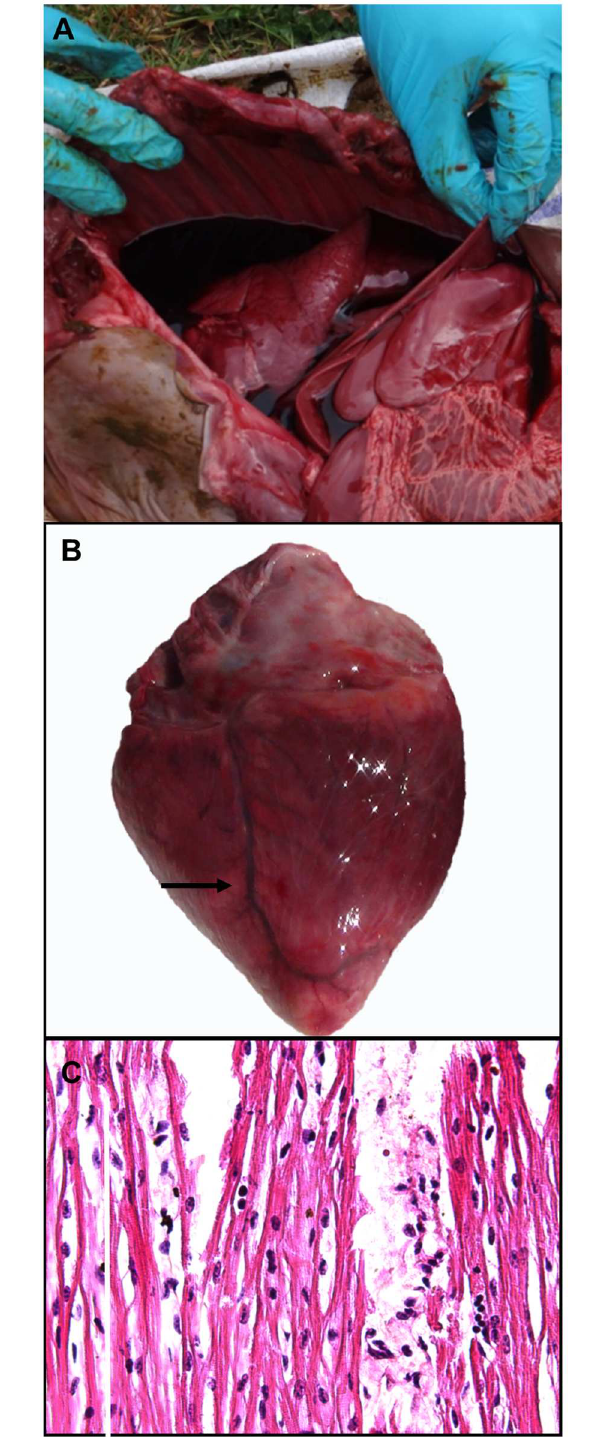
Fig 1. Gross and histopathological findings of FMDV-associated myocarditis in still-borne calf. (A) Sanguineous bicavitaryeffusions in still-bornecalf from Dam ID#454. (B) Focal myocarditis seen as area of pallor (arrow) on epicardialsurface of heart from aborted calf shown in panel (A). (C) Mixed mononuclear infiltrate and interstitial edemaseparatingmyocardialfibers in histological specimenfrom heart. Hypereosinophiliaand loss of striations indicatesmyofiber degeneration and necrosis. Hematoxylin and Eosin stain. 40x magnification.